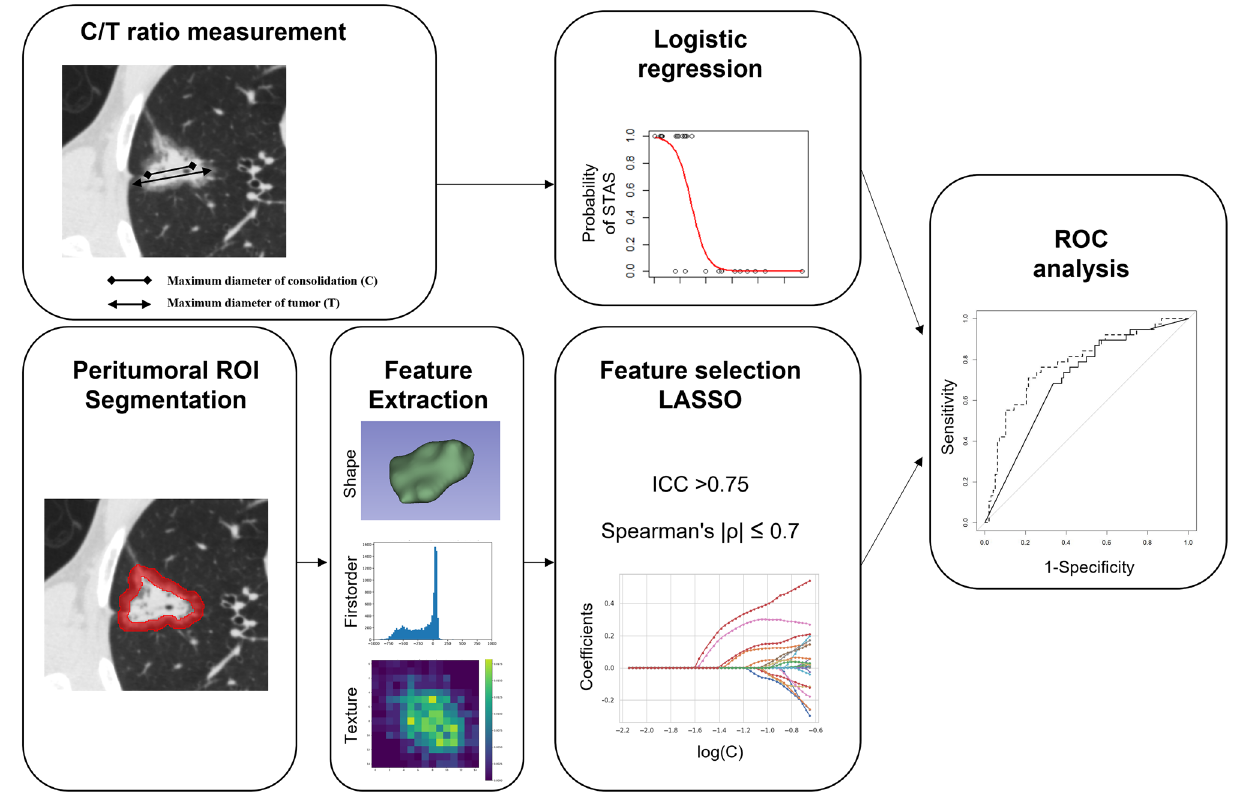
Figure 2. Workflow of the predictive model